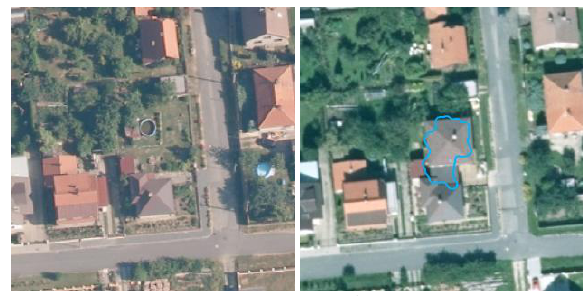
Figure 7. True indication of a new